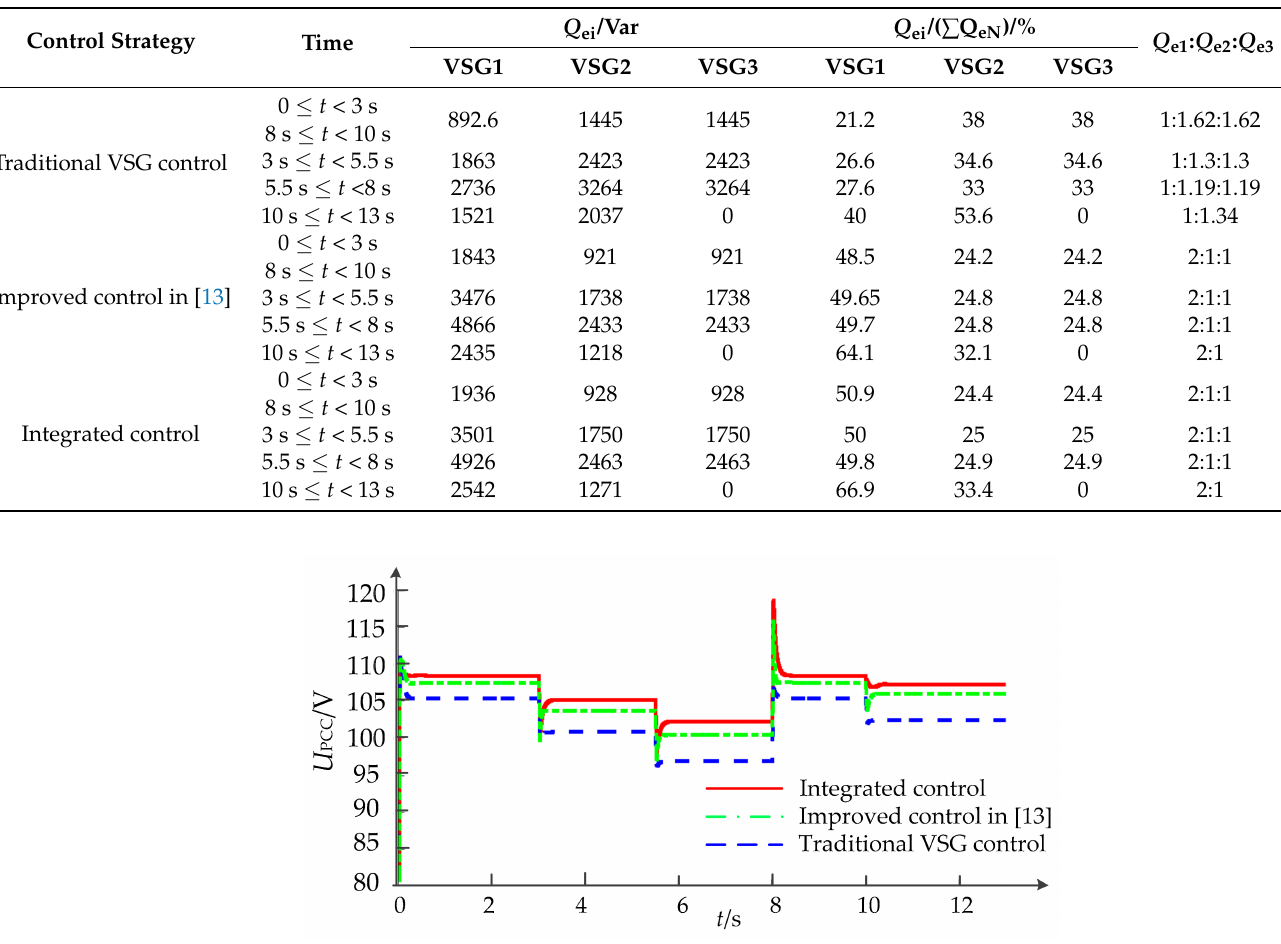
Table 3. Steady-state values of reactive power with different control strategies.